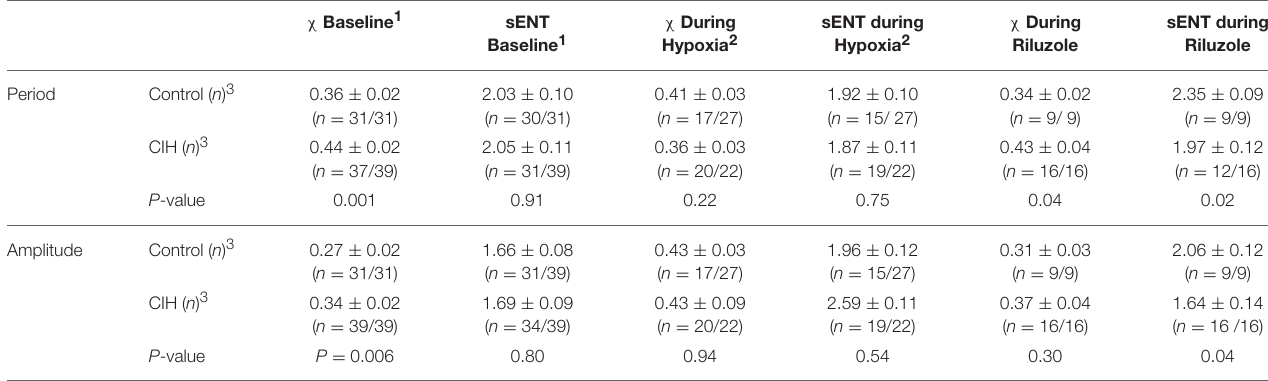
TABLE 1 | The fluctuation value ( χ ) and sample entropy (sENT) for period and amplitude during baseline, hypoxia, and in riluzole.